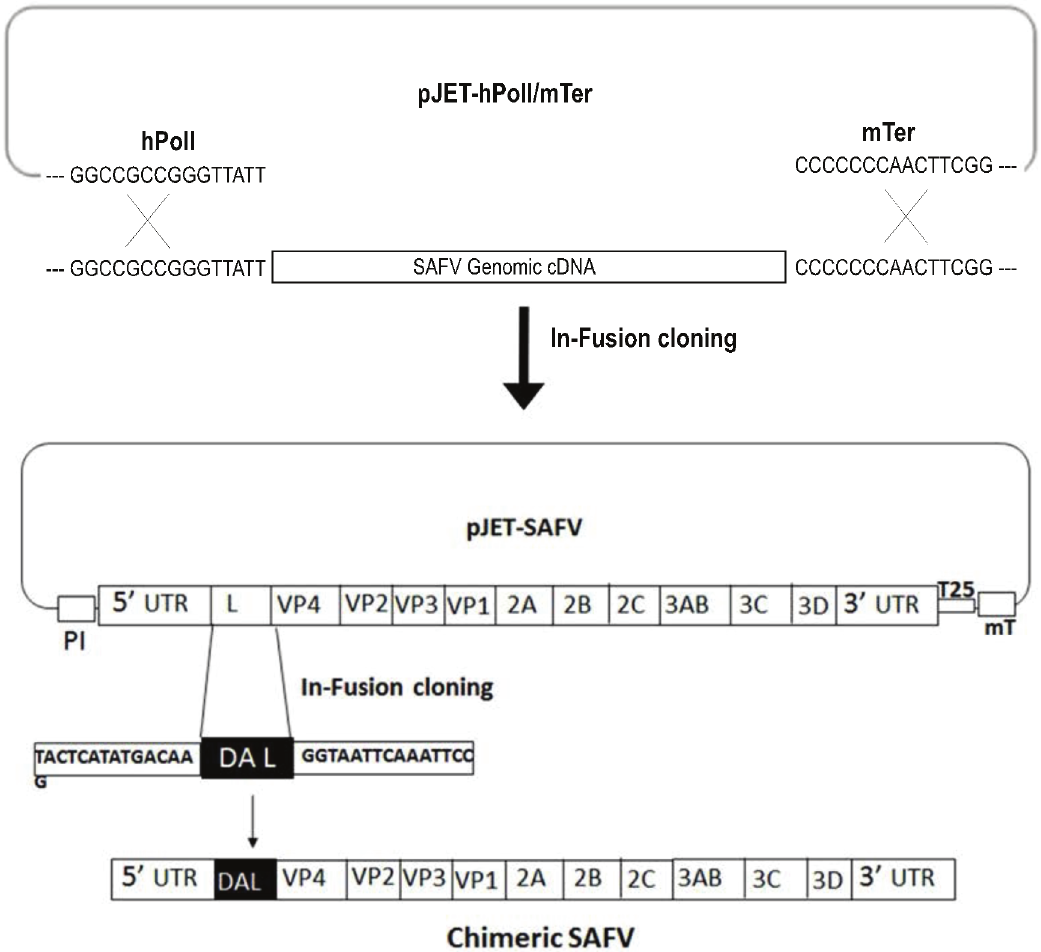
Figure 1. Strategy for the construction of SAFV and chimeric SAFV constructs. The pJET-SAFV plasmid was generated by insertion of SAFV cDNA amplicon into pJET-hPolI/mTer. Further, DA L gene from TMEV was flanked with linear pJET-SAFV between 5'UTR and VP4 using an In-Fusion cloning method. After transfection of pJET-DAL-SAFV into Vero cells, chimeric SAFV virus was rescued. PI: human polymerase I promoter; 25: poly (A) tail with 25 As; mT: murine terminator.